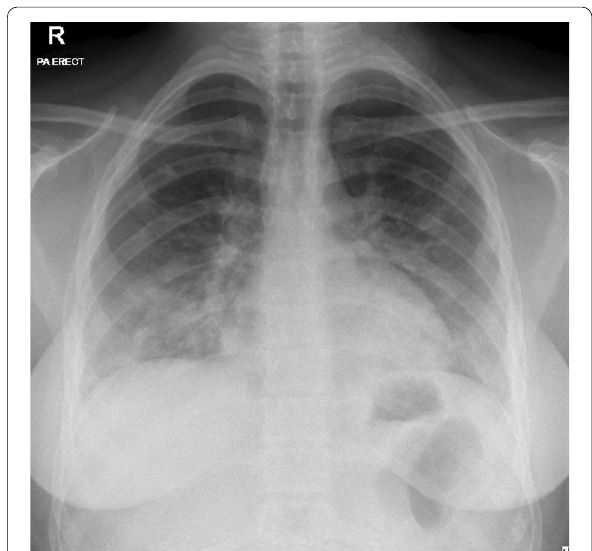
Fig. 3 A 16-year-old girl with COVID-19 pneumonia based on positive RT-PCR test who presented with fever and cough for 3 days. Frontal chest radiograph shows bilateral multifocal ground-glass opacities and consolidations. The patient’s serum biochemical parameters show a significantly elevated LDH level of 260 U/L